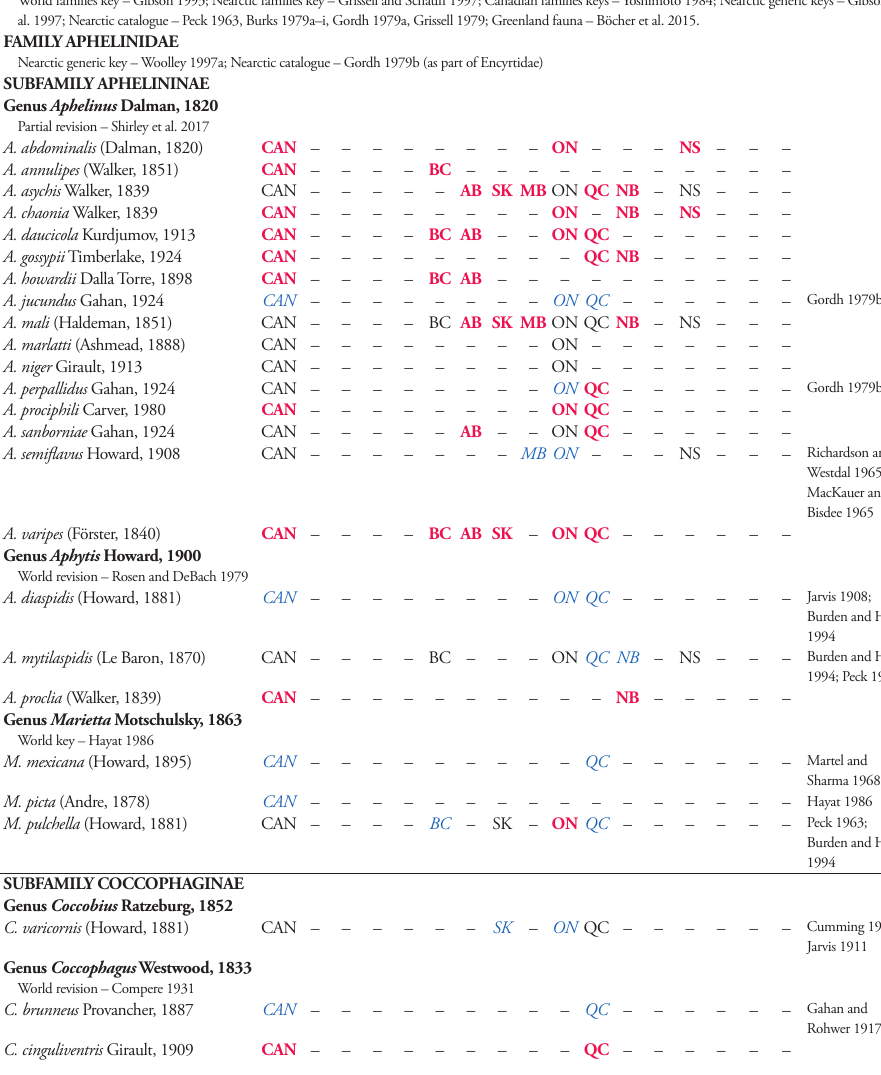
Table 2. Checklist of species of Chalcidoidea and Mymarommatoidea of Canada, Alaska and Greenland. See Methods for acronyms used for the regions. Distributional acronyms in black regular font are previ- ously published and supported by an examined specimen. Red, boldface records are new (unpublished) records supported by an examined specimen. All specimens supporting boldfaced records are deposited in the CNC except if a depository acronym is noted in the far right column. Blue, italicized records are previously published but not validated by an examined specimen. Literature references are only noted for italicized records. For species with multiple italicized records based on multiple references, the references are listed in order from left to right, corresponding with the distributional records depicted from left to right, unless otherwise noted. An asterisk (*) denotes a record from Newfoundland for which it is uncer- tain whether it was from the island of Newfoundland or mainland